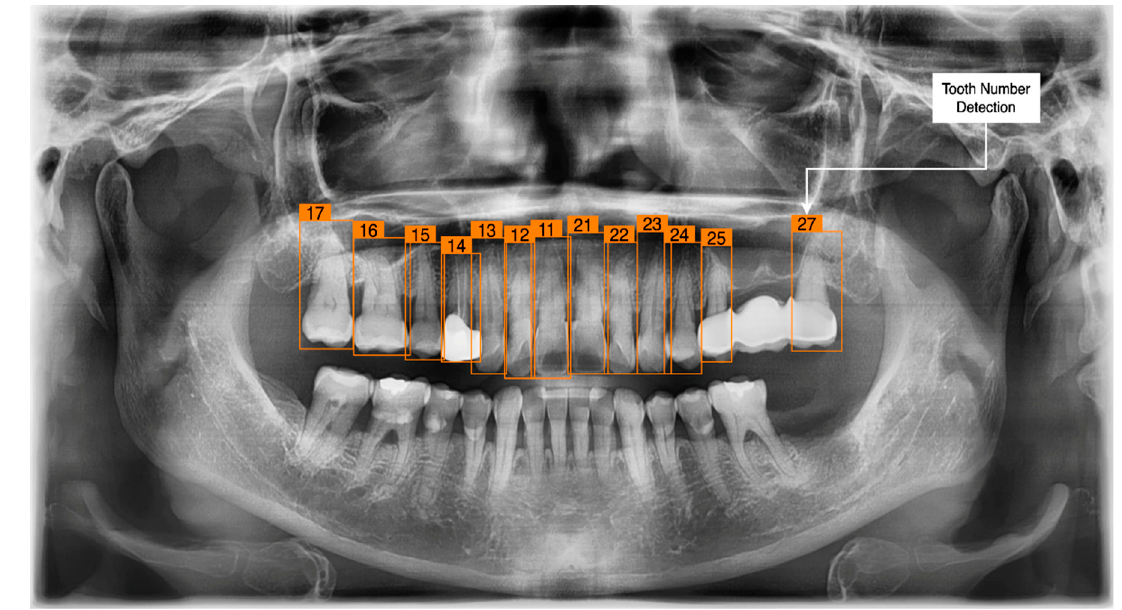
Figure 7. Automatic tooth numbering using a YOLOv5 model.